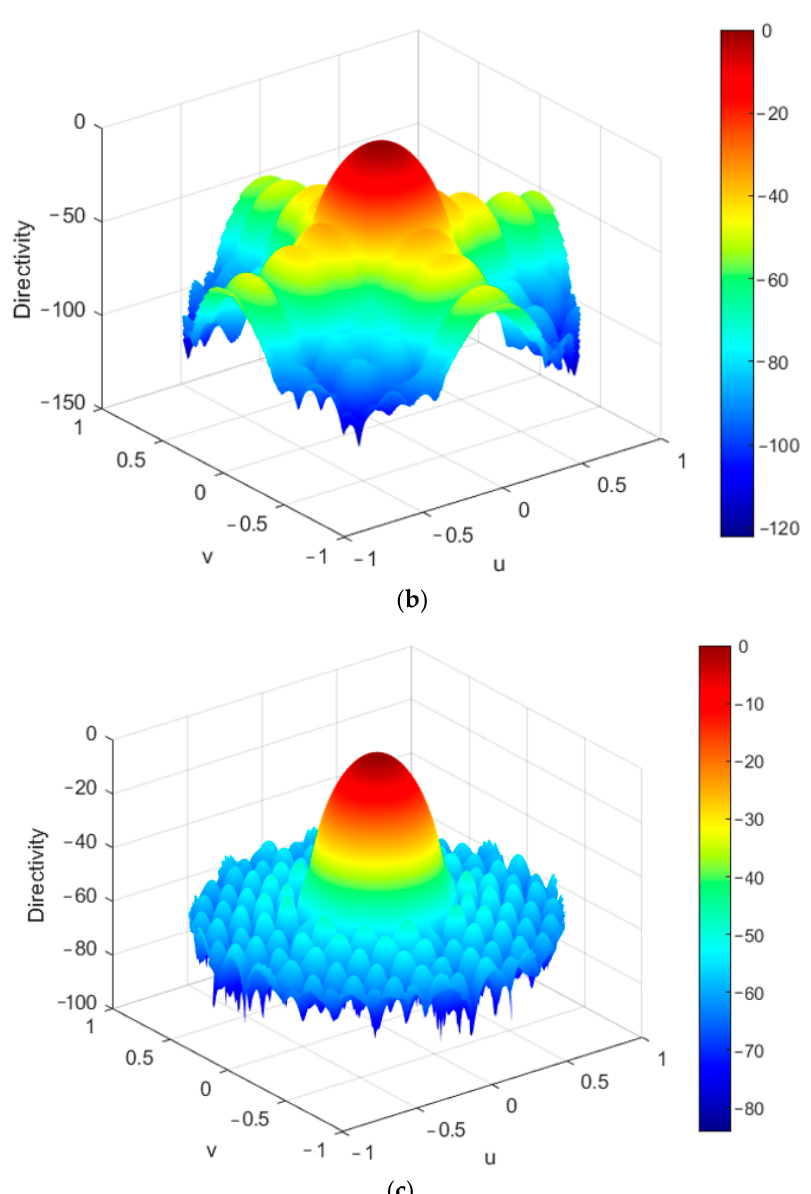
Figure 15. ( a ) 2D 20 × 20 crossed-dipole antenna array in the XY plane, ( b ) normalized power pattern for Blackman cross-linear tapered array, and ( c ) normalized power pattern for Blackman radial-tapered array at 𝜇 = 0.86 .